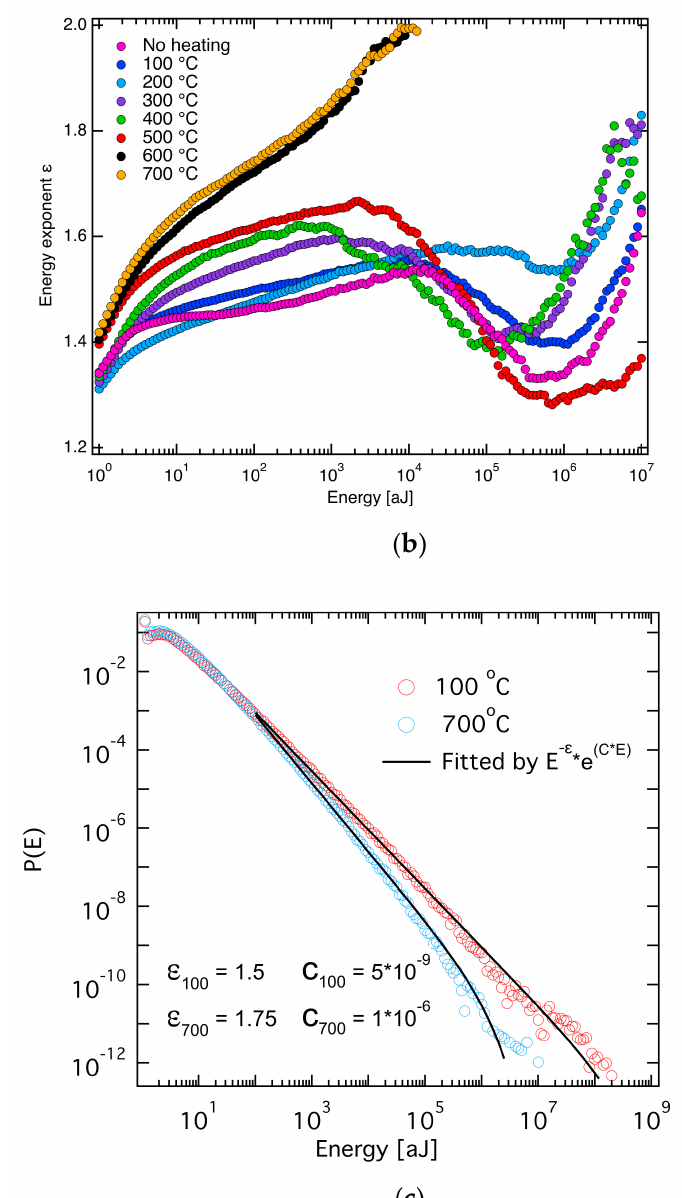
Figure 8. ( a ) Distribution of avalanche absolute energies for different temperatures. ( b ) The ML- fitting exponent ε as a function of a lower threshold E min . ( c ) Damping and pure power fitting for the distribution of avalanche absolute energies of 100 ◦ C and 700 ◦ C. Reproduced with permission from [72]. De Gruyter,